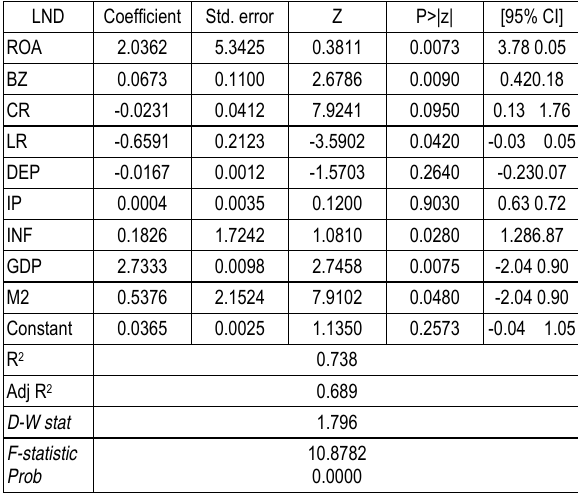
Table 6. Results of